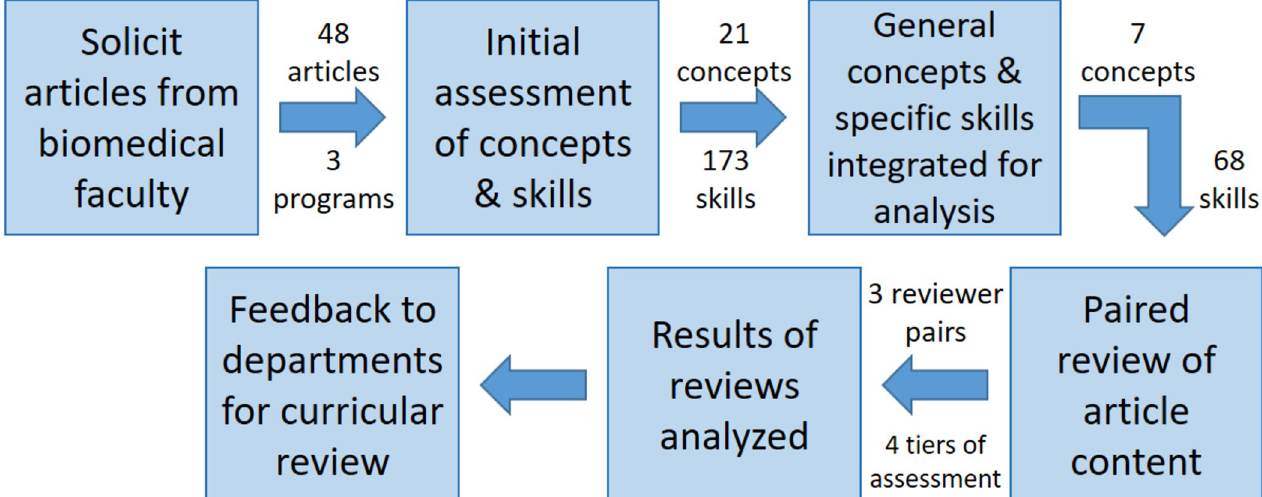
Fig 1. Data collection and analysis. Process for data collection and analysis of articles chosen by faculty as appropriate for all biomedical students completing a PhD in their program to read with comprehension. See main text for details of the steps taken for collection of data and analysis.